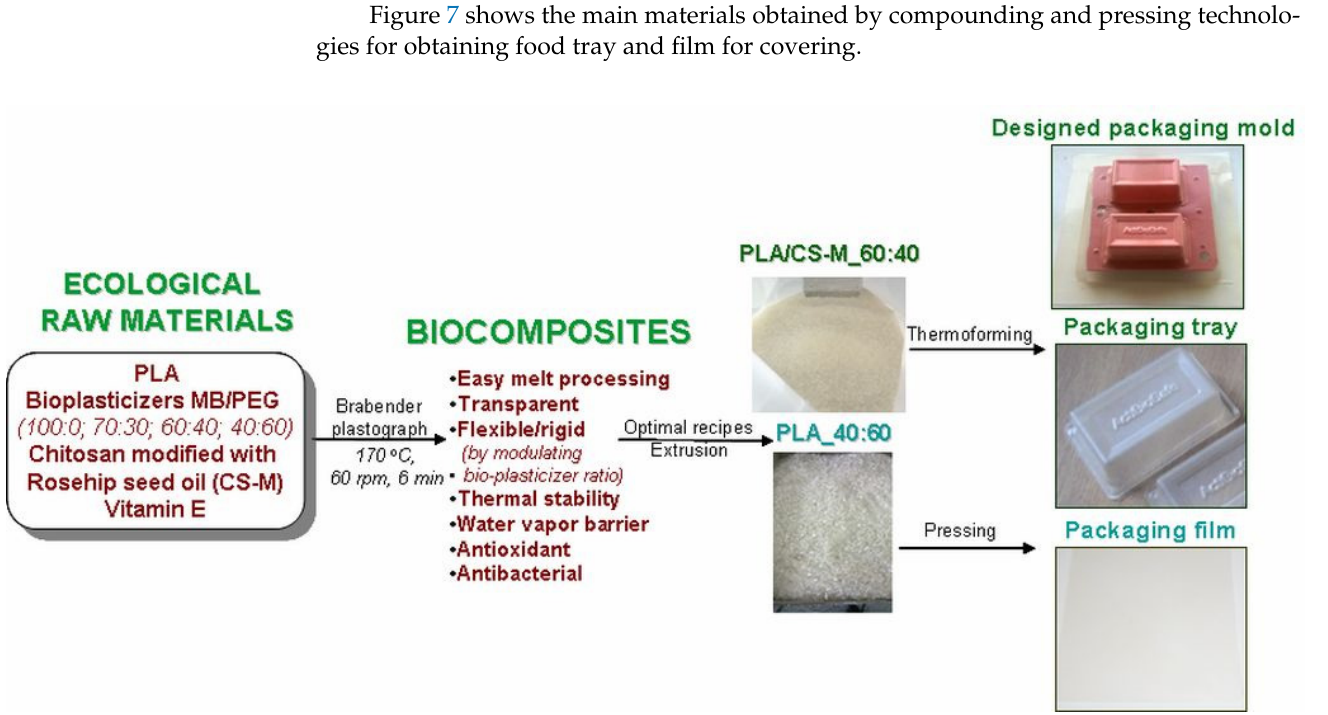
Figure 7. Overview of the main technological steps for obtaining of food packaging